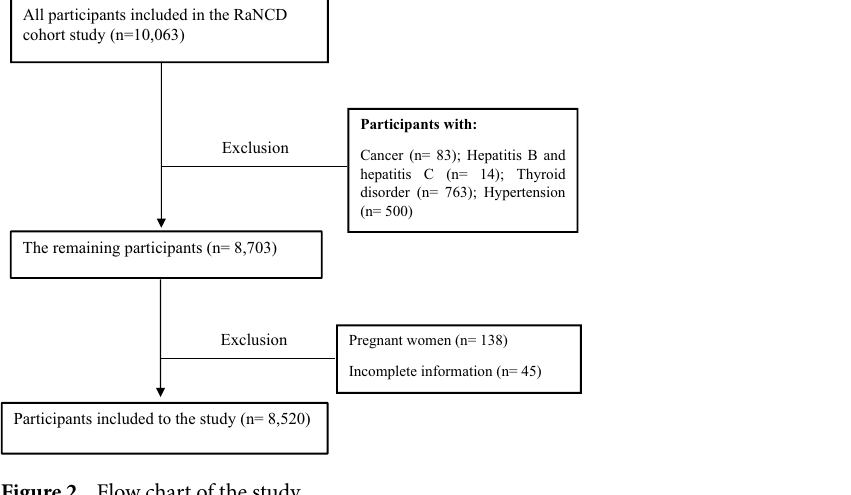
Figure 2. Flow chart of the